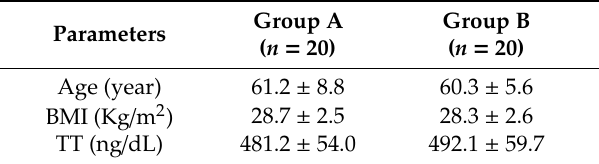
Table 1. Baseline values of the entire